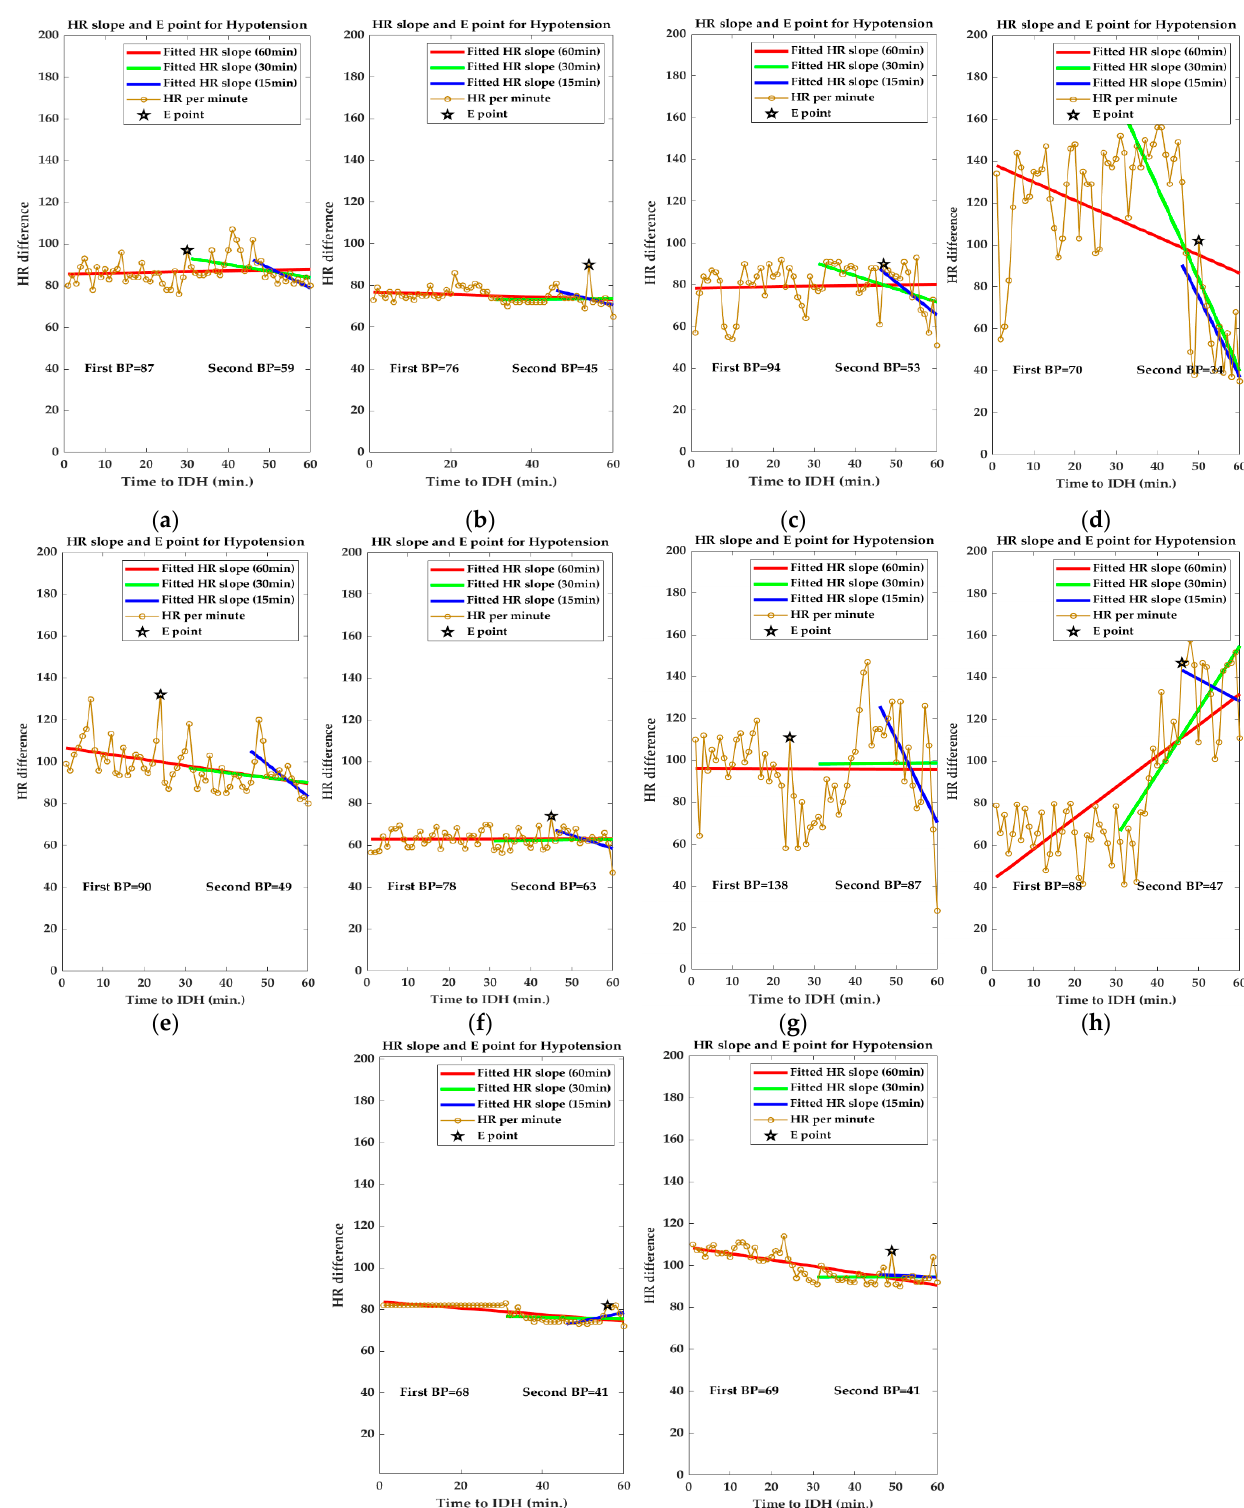
Figure 4. Changes in slope of HR per minute before IDH. (Figures 4a–h and 4i,j show the decreasing and increasing trend of the mean HR slope respectively.)